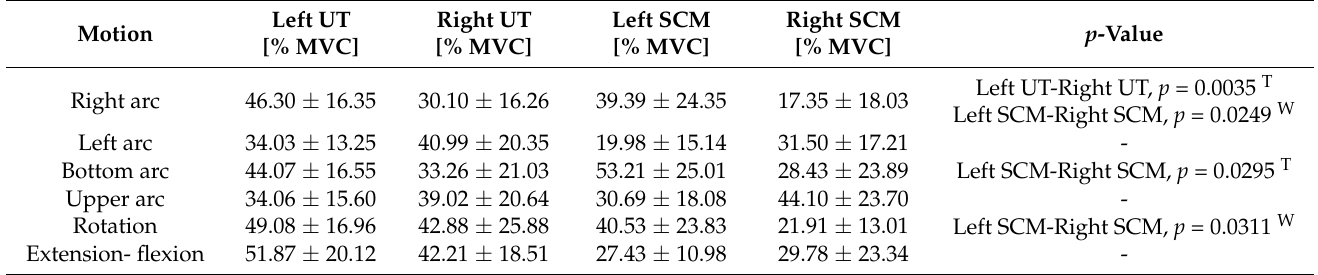
Table 2. Statistically signi fi cant di ff erences for t -test ( T ) and Wilcoxon’s ( W ) test for dependent groups in mean muscle activity, p < 0.05.